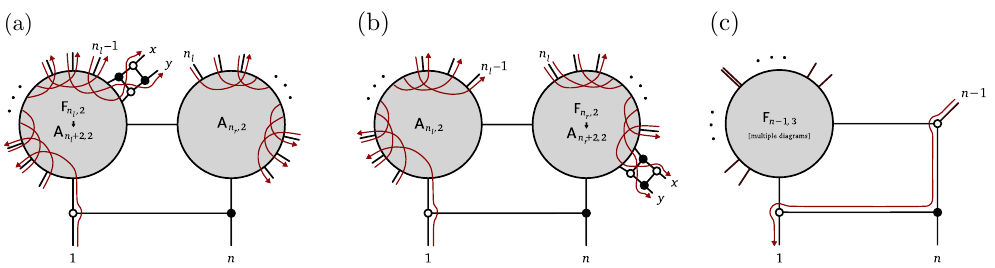
Figure 1 . Structure of left-right paths for the three types of terms contributing to the NMHV form factor in the BCFW recursion